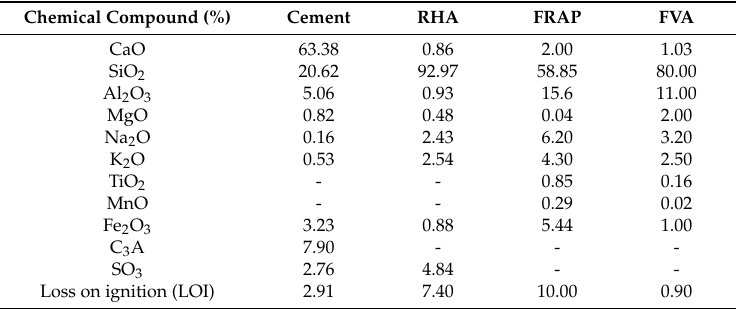
Table 4. Chemical composition of cement, RHA, FRAP, and